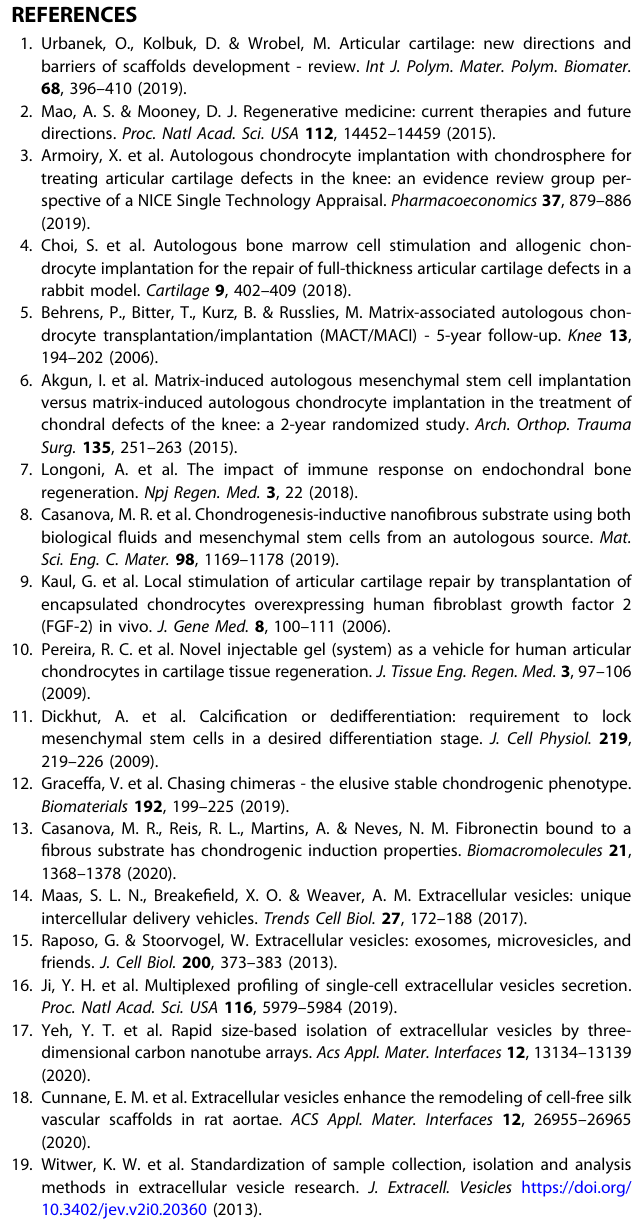
Gene Forward (5 ′ − 3 ′ ) Reverse (5 ′ − 3 ′ )